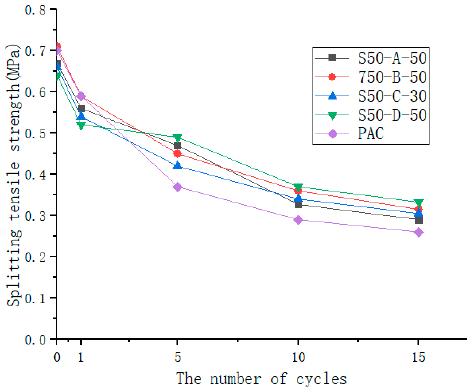
Figure 10. Splitting tensile strength after freeze-thaw cycle.